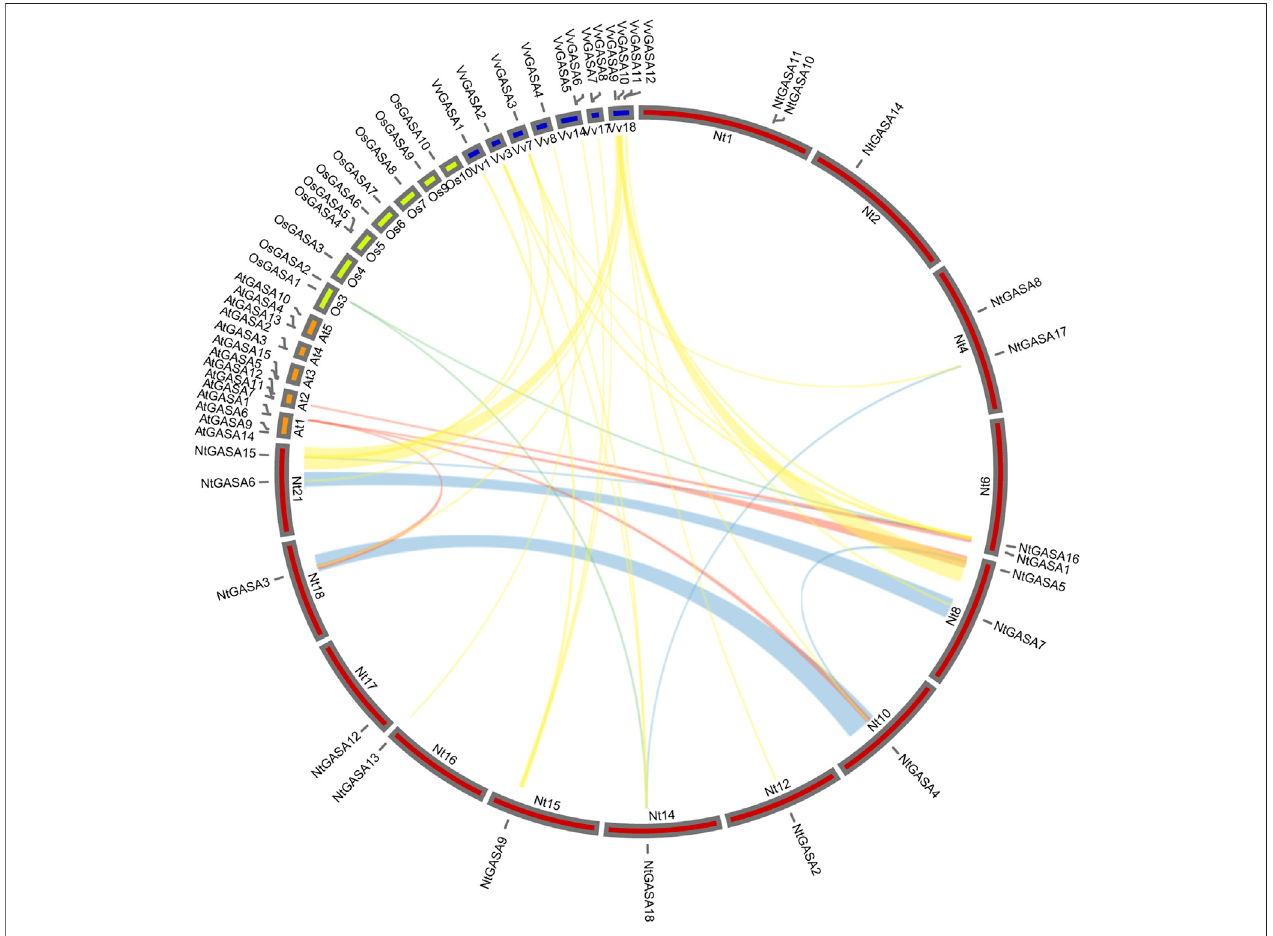
FIGURE 3 | Collinear analysis of GASA genes between tobacco(Nt), grapevine(Vv),rice(Os), and Arabidopsis (At). Yellow,red and cyanlines representthecollinear gene pairs between tobacco and grapevine, tobacco and Arabidopsis , tobacco and rice chromosomes, respectively. Blue lines indicate the segmental duplicated NtGASA genes.